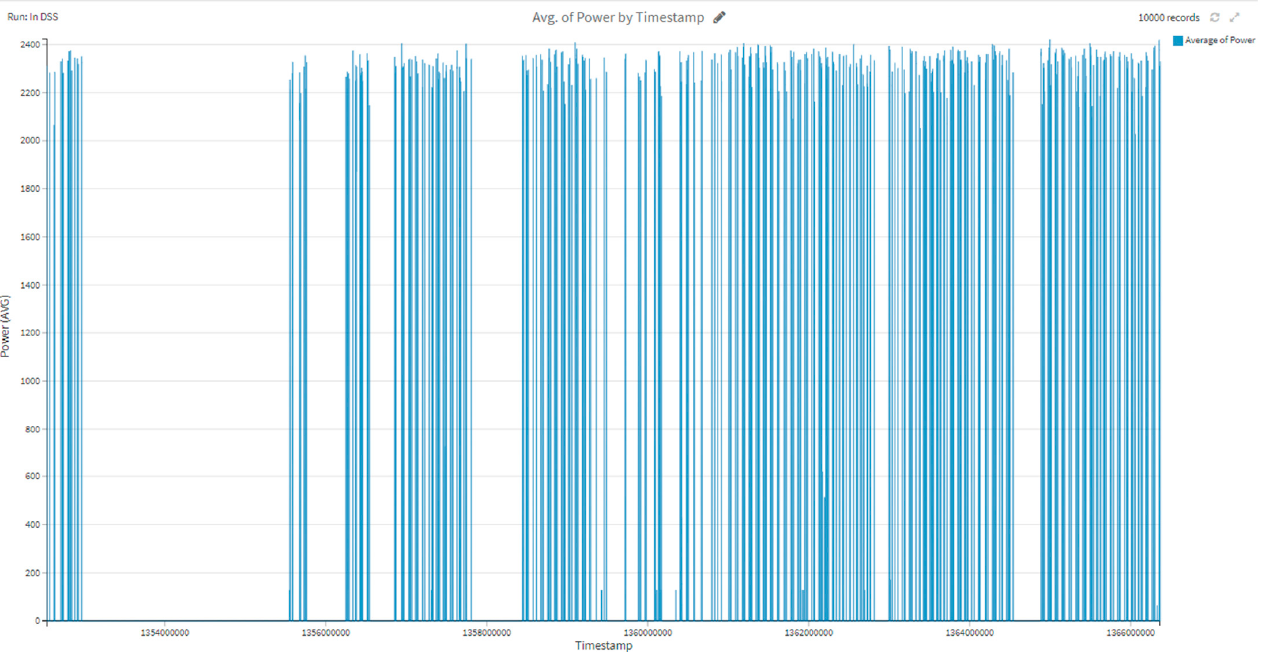
Figure 9. Graphic representation of the use of kettles/heater over time.